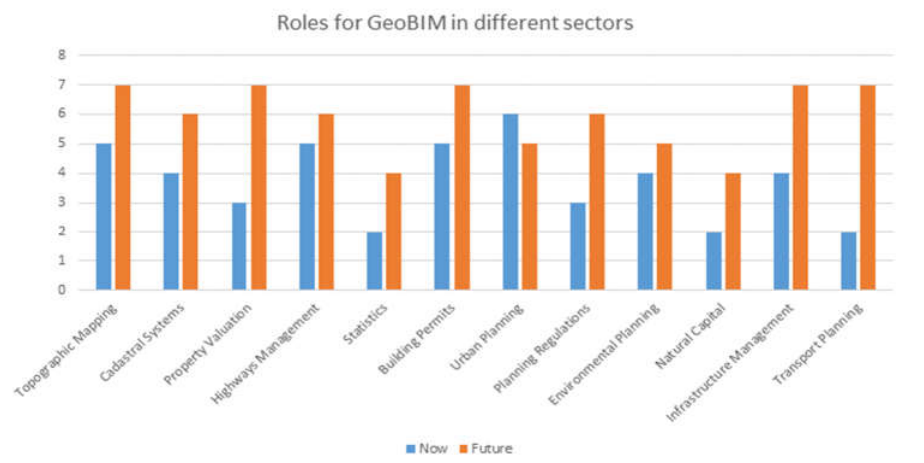
Figure 4 - Current and Future Opportunities for GeoBIM